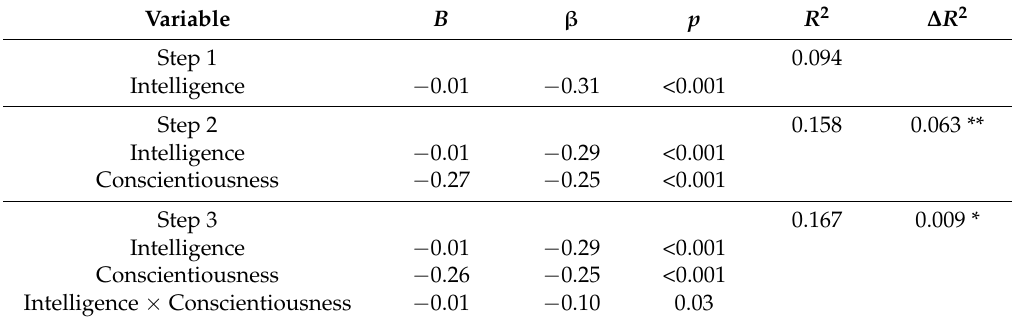
Table 2. The hierarchical regression of grade point average on centered intelligence and conscientiousness.